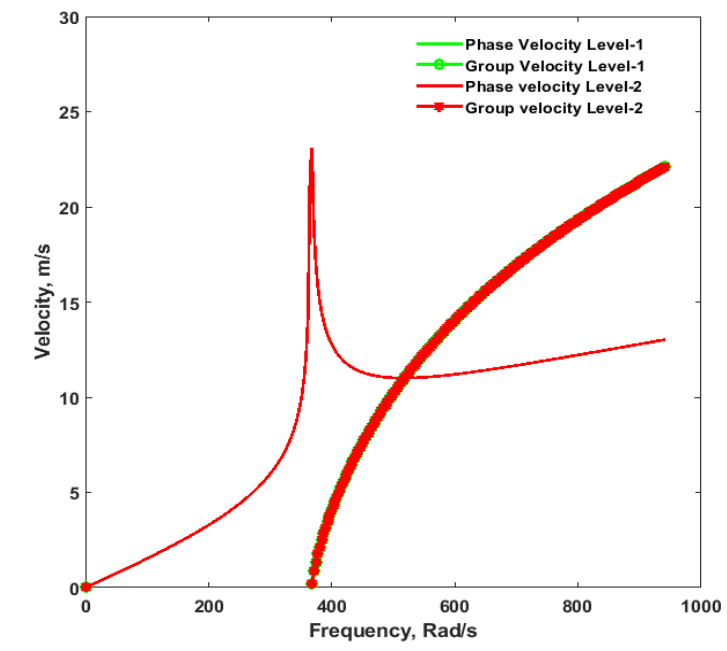
Figure 2. Comparison of Dispersion Curves for Level-1 and Level-2.